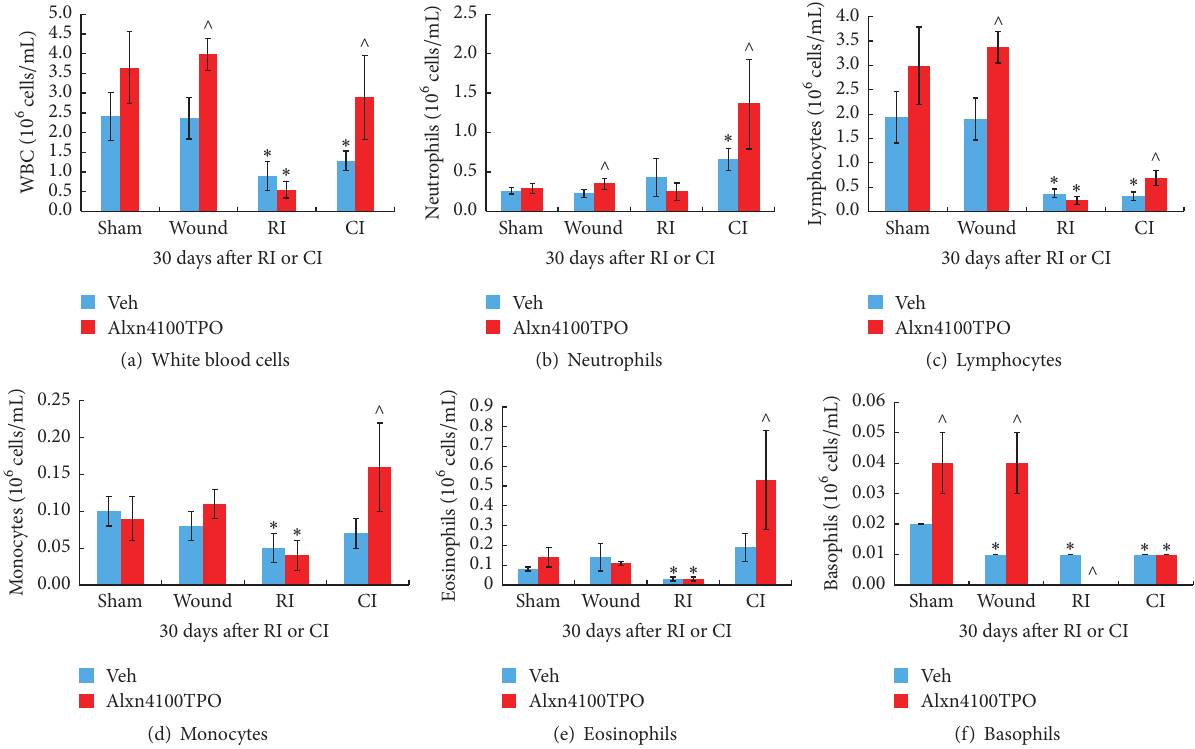
Figure 3: RI and CI decreased WBC, but Alxn4100TPO significantly mitigated only the CI-induced WBC decrease. Numbers of WBC and component cell categories in mouse blood samples collected 30 days after RI and CI were determined. 𝑁 = 4–6 per group. Data are presented as mean ± SEM. ∗ 𝑝 < 0.05 versus Vehicle Sham; ∧ 𝑝 < 0.05 versus respective vehicle group. RI: 9.5 Gy; CI: 9.5 Gy and skin